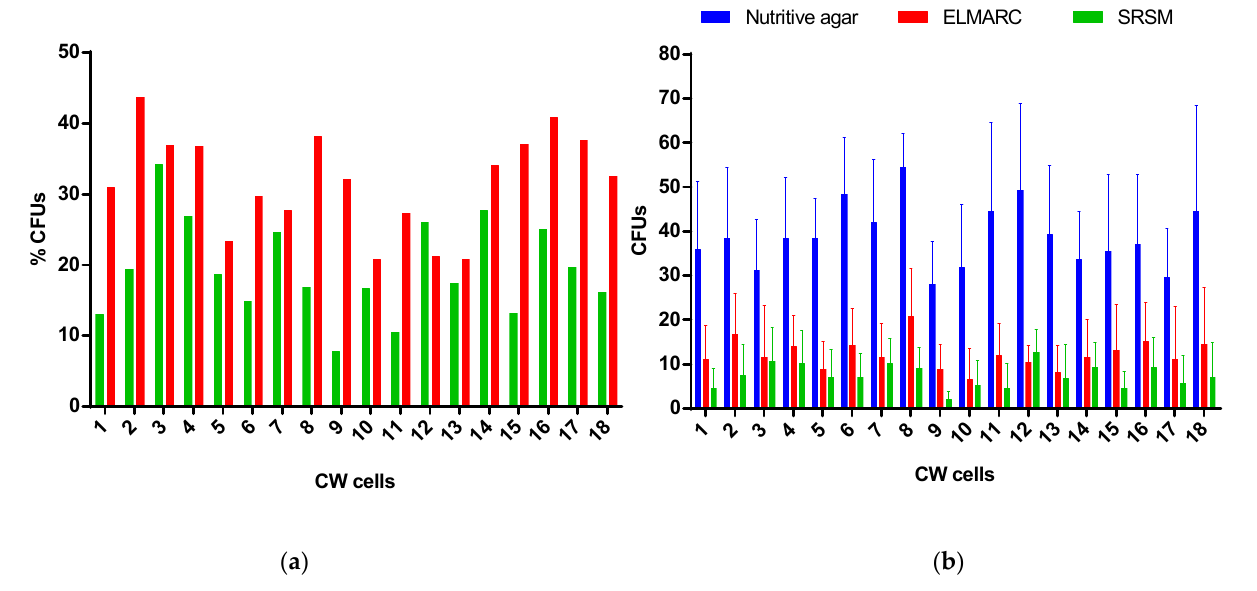
Figure 7. Percentage of CFUs inside the CW cells: ( a ) nitrogen-fixing bacteria and phosphorus-solubilizing bacteria; ( b ) total count of bacterial CFUs.